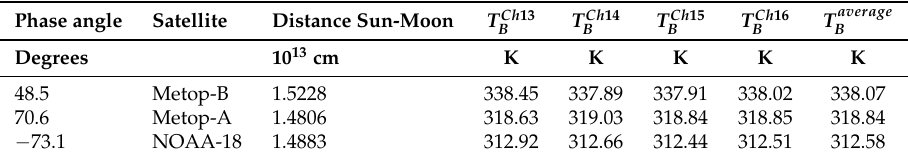
Table 7. Brightness temperature of the Moon in the four channels with central wavelengths around 4.5 µ m for three different phase angles. T B is the brightness temperature of the Moon after subtraction of the reflected sunlight.